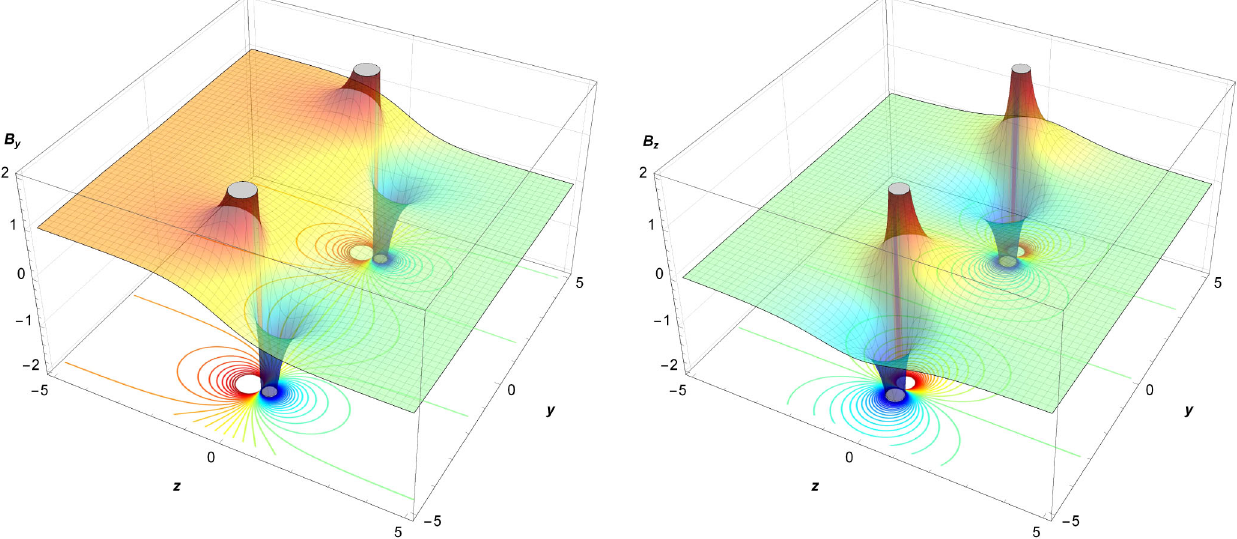
FIG. 1. Field components B and B in the fringe field region of a dipole magnet. The falloff of the field in this case in the plane y z y ¼ 0 is given by a single-parameter Enge function.